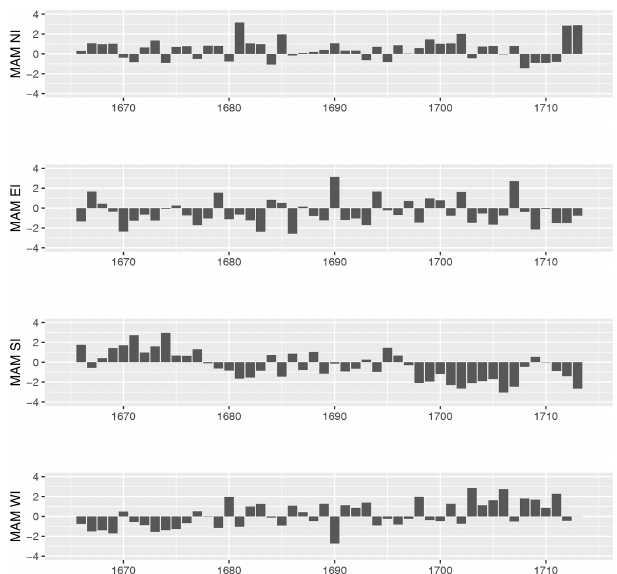
Figure A5. Standardized MAM DI time series for the LMM (1665– 1713) with respect to the mean of the reference period of 1981–